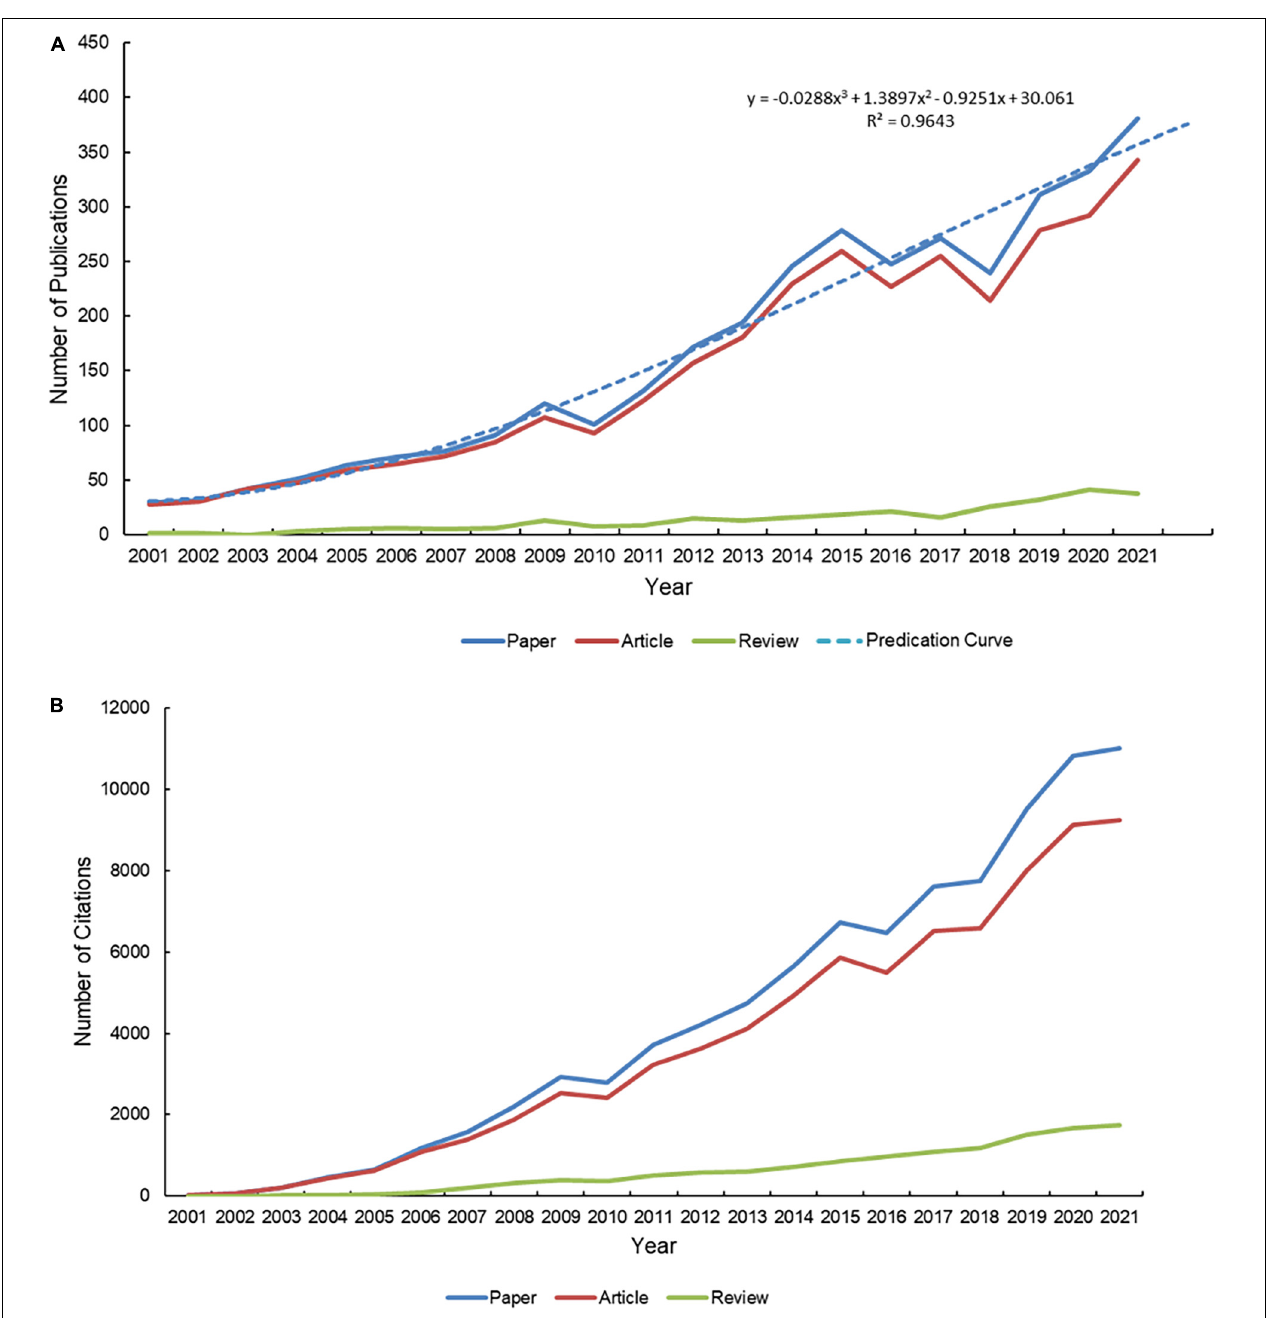
FIGURE 1 | Trends of publications and citations. (A) Trends of publication outputs and growth prediction from 2001 to 2021. (B) Trends of citations received by publications from 2001 to